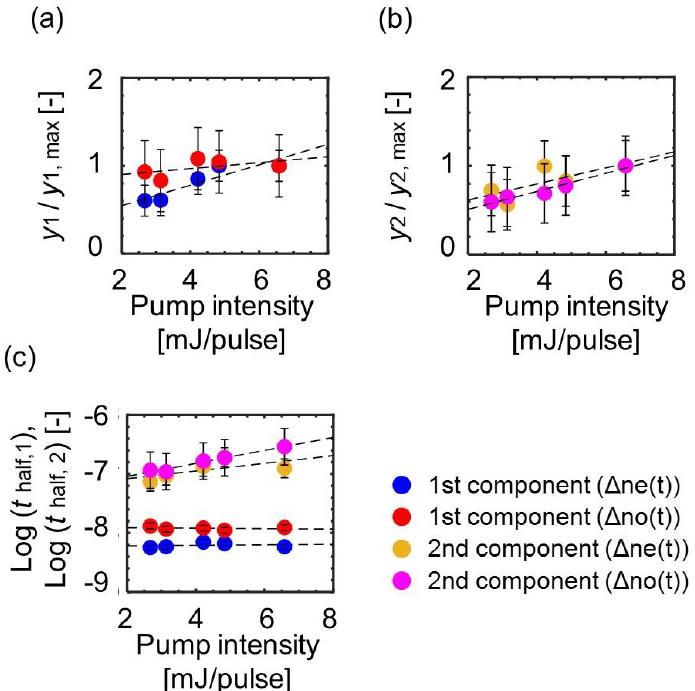
Figure 5. The parameter dependences on the probe polarization and the pump intensity: the area of the disordered region when ( a ) the first and ( b ) the second disordering processes finished, whose parameter values were divided by those at a pump intensity of 6.58 mJ/cm 2 ; ( c ) the log half-time for each disordering process.